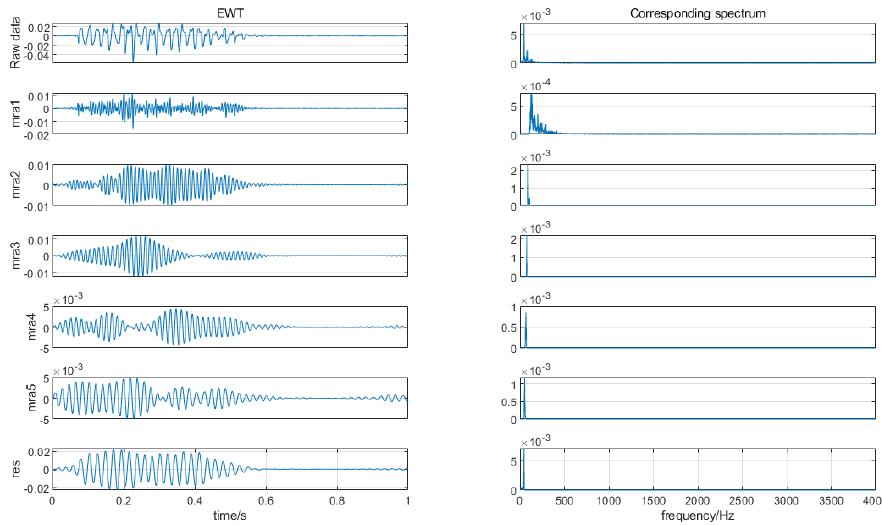
Figure 4. Blasting vibration signal EWT and spectrogram.